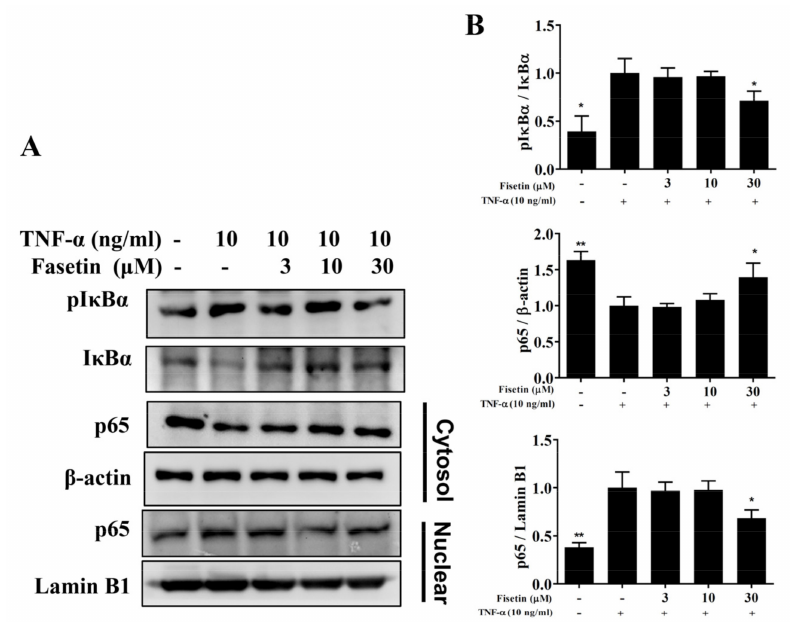
Figure 4. Fisetin treatment suppressed nuclear translocation of NF- κ B in TNF- α -induced BEAS-2B cells. ( A ) Fisetin regulated NF- κ B pathway expression ( n = 3 per group). ( B ) The fold expression of pI κ B α and p65 in the cytoplasm, and the levels of p65 in the nucleus. The data presented as mean ± SEM of three independent experiments. * p < 0.05, ** p < 0.01, compared to the TNF- α - stimulated BEAS-2B cell control.